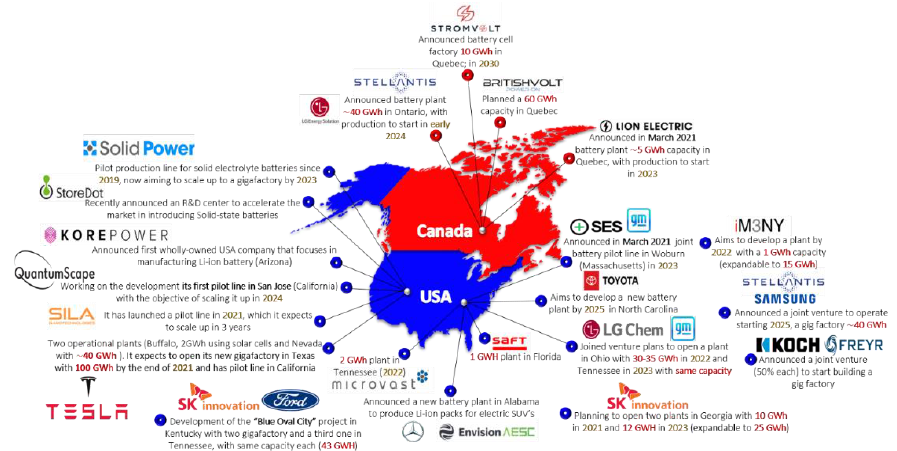
Figure 1. North American battery initiatives.